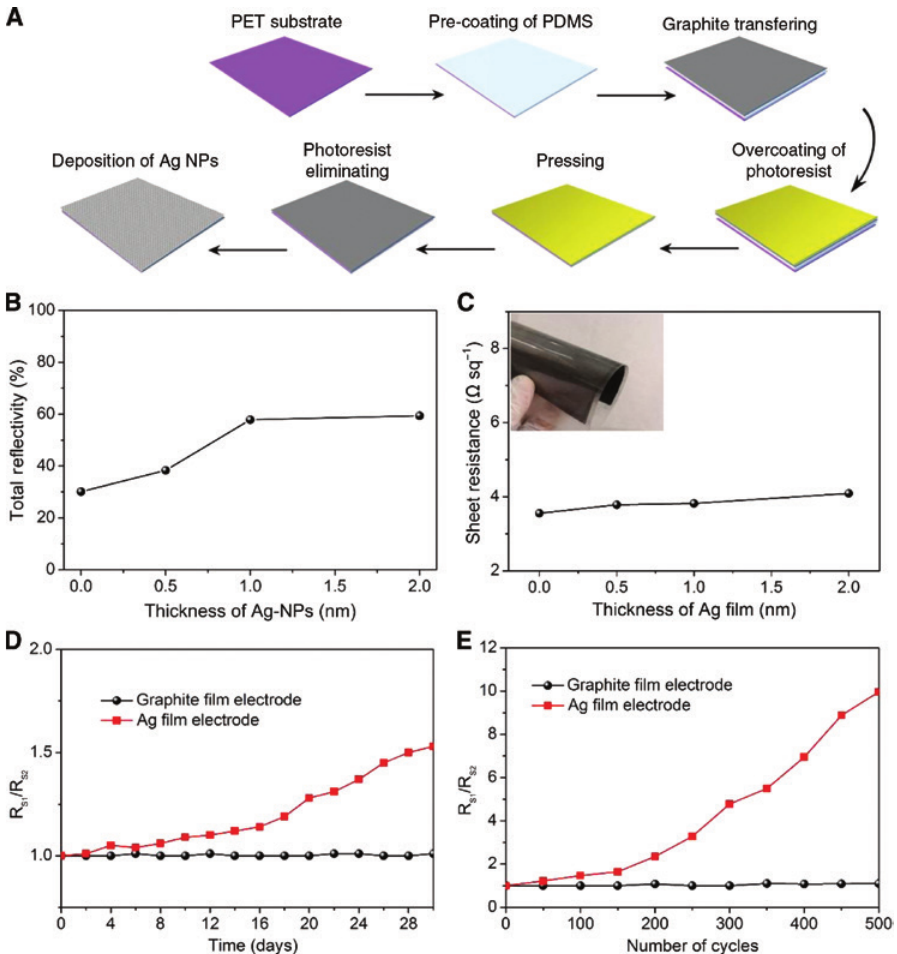
Figure 1: The fabrication process of Ag-modified graphite electrode and characterisation. (A) Schematic diagram showing the fabrication procedure of ultrathin Ag-modified graphite bottom electrode. (B) Reflectivity of ultrathin Ag-modified graphite films as a function of the Ag layer thickness. (C) Sheet resistance of ultrathin Ag-modified graphite films as a function of the Ag layer thickness. Inset: Photograph of a graphite film (15 cm × 20 cm). (D) R air exposure (room temperature) for 30 days. (E) Dependence of resistance of the electrode on the number of bending cycles. R correspond to the resistance before and after bending,